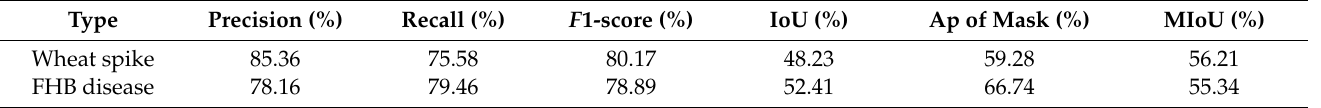
Table 4. Results of BlendMask for wheat spikes and FHB disease